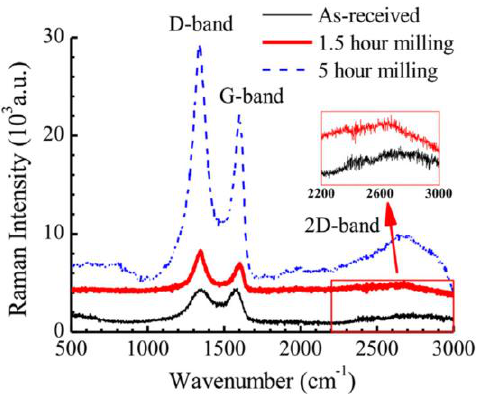
Figure 1. Raman spectra of the milled Al6061-2.0 wt.% graphene powder at different milling times and as-received graphene [50]. (Reproduced from [50] with permission; Copyright 2014 Elsevier).